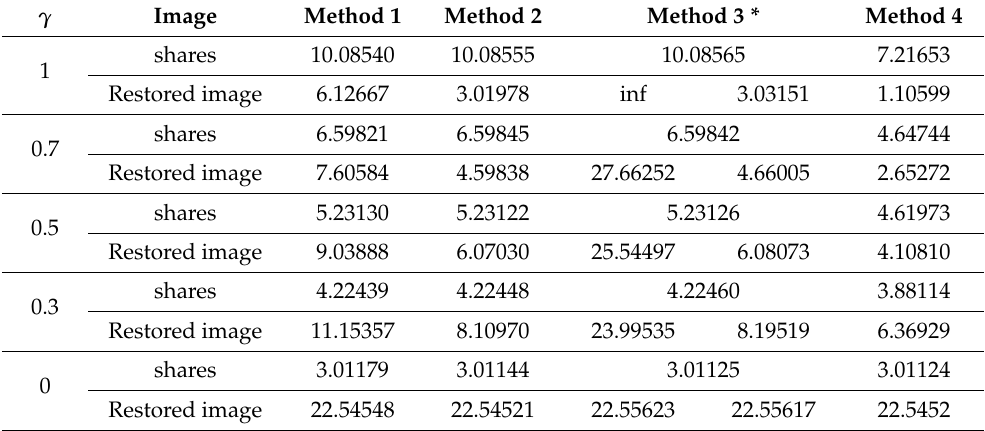
Table 3. The PSNR analysis of the proposed